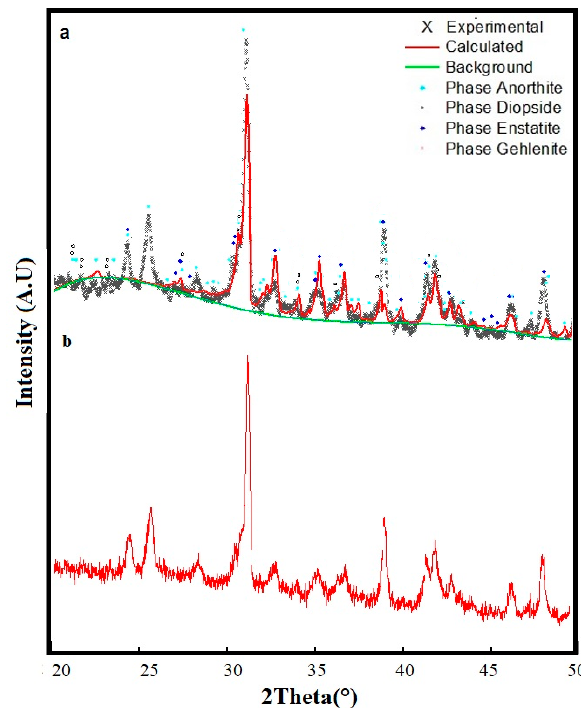
Figure 11. X-ray diffraction patterns: (a) Mixture 1 at 1200 °C with the annealing process at 930 °C and Figure 11. X-ray di ff raction patterns: ( a ) Mixture 1 at 1200 ◦ C with the annealing process at 930 ◦ C and 1100 °C for 2 h; (b) Mixture 1 at 1200 °C. 1100 ◦ C for 2 h; ( b ) Mixture 1 at 1200 ◦